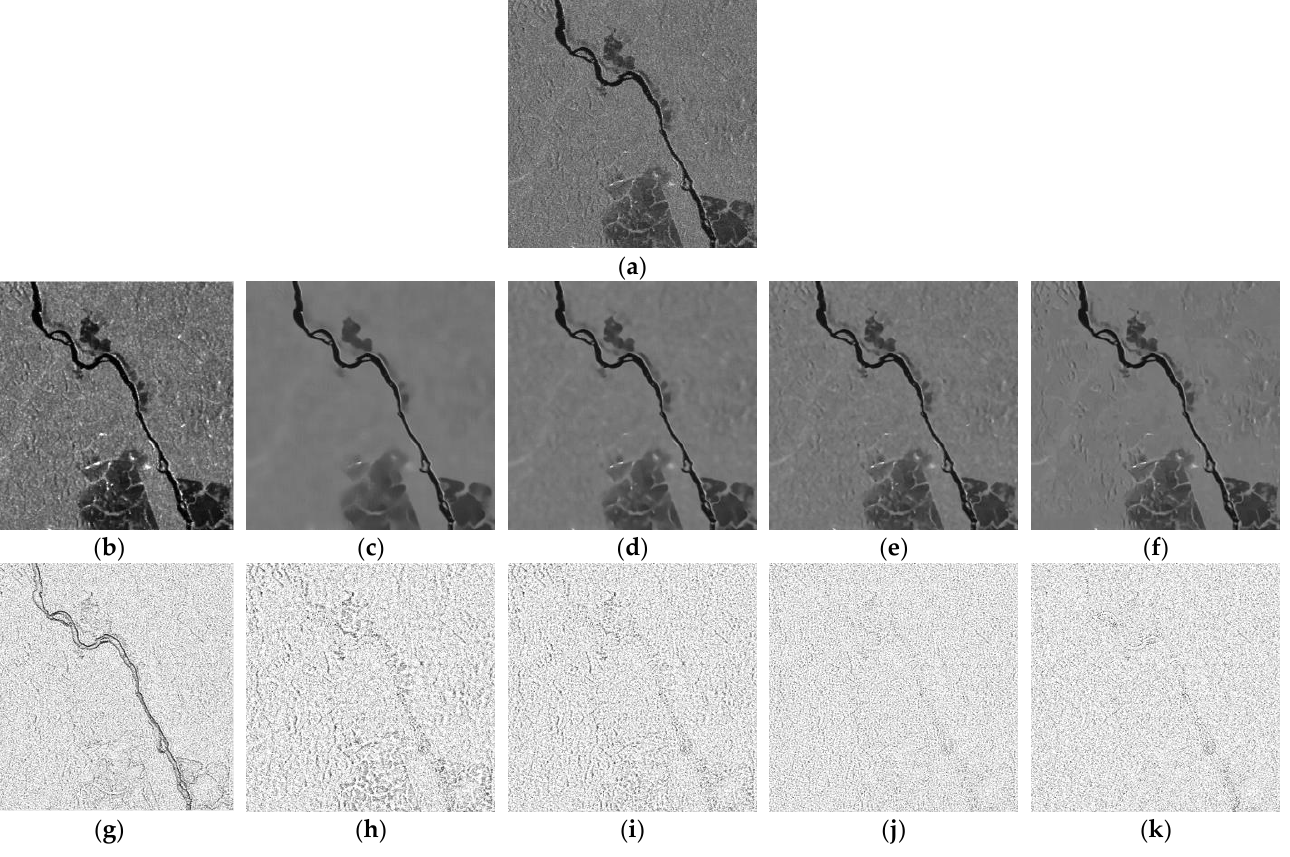
Figure 5. Filtering results for the ALOS Image. ( a ) The speckled image. ( b ) The SRAD filtered image. ( c – e ) are, respectively, the PPB filtered image when T = 4, T = 3, and T = 2. ( f ) The SAR-BM3D filtered image. ( g – k ) are the corresponding ratio images of ( b – f ). Table 4. EPC assessment results for the ALOS image.